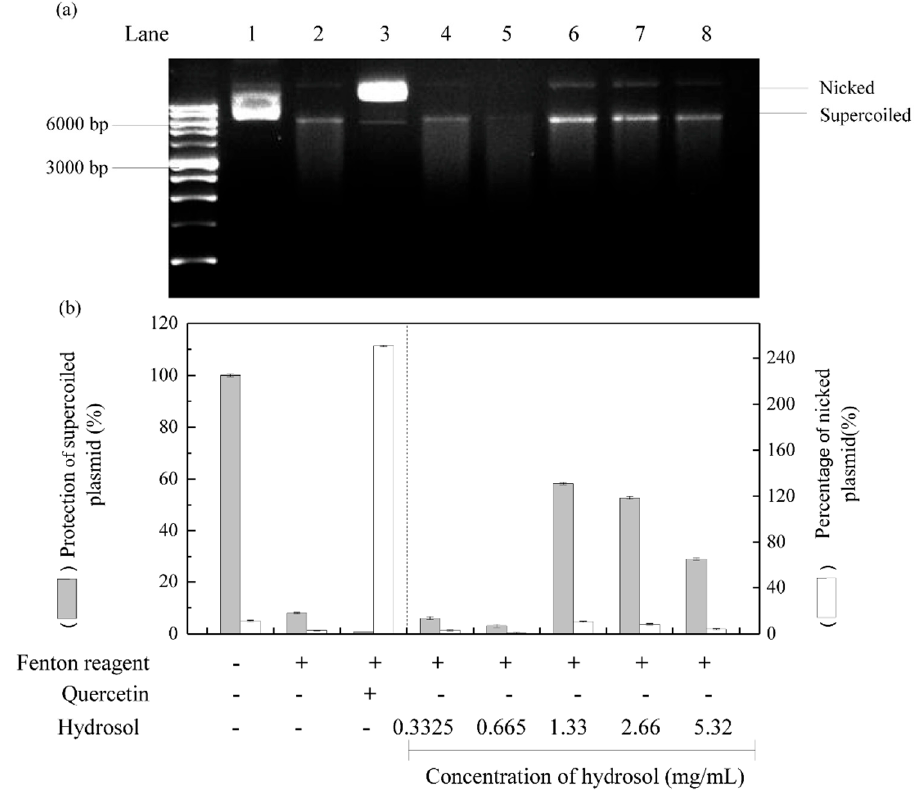
Figure 6. E ff ects of hydrosol in pCI neo DNA protection assays; ( a ) agarose gel of pCI neo DNA after exposure to Fenton reagents and protective treatments; ( b ) percentage quantification of supercoiled and nicked pCI neo forms; Lane 1, pCI neo DNA, negative control; Lane2, pCI neo + Fenton reagents, negative control; Lane3, pCI neo + Fenton reagent + 250 mg / mL quercetin, positive control; Lanes 4–8, pCI neo + Fenton reagent + various concentrations of hydrosol.